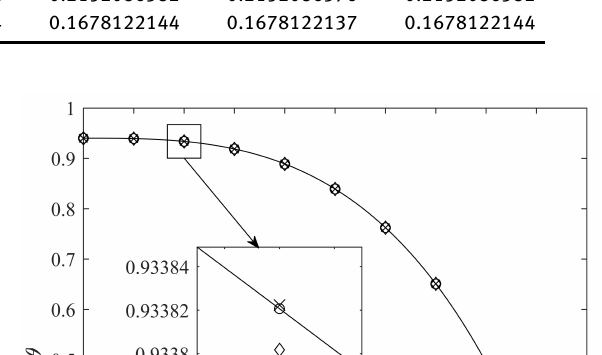
The error remainder function for (26) is